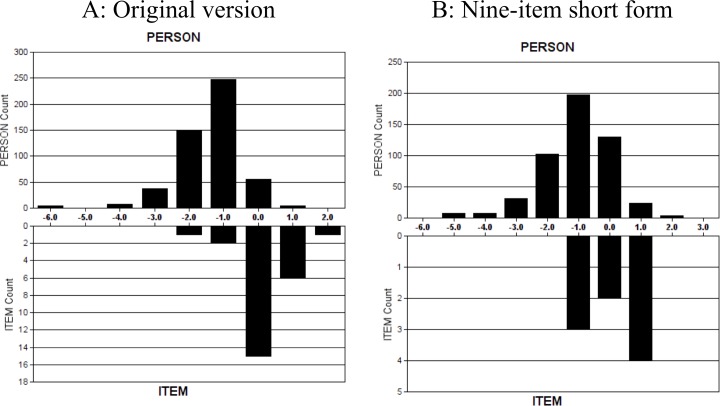
Item–person threshold map.A. Original version. B. Nine-item short form. Persons of lesser central sensitization and easier items are located on the left side of the logit scale (i.e. < 0 logits); persons of higher central sensitization and greater difficulty items are located to the right of the logit scale (i.e. > 0 logits). Item endorsability mean is set at 0 logits by default.